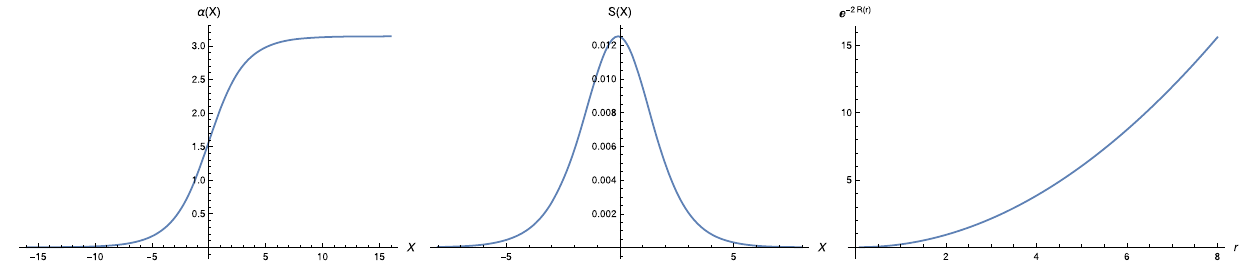
Fig. 1 From left to right, the α profile and the Ricci scalar S as functions of the X coordinate and metric function e − 2 R ( r ) as a function of the r coordinate